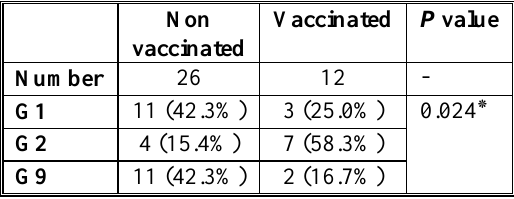
Number of patients (n) and percentage (%) Chi-square test was